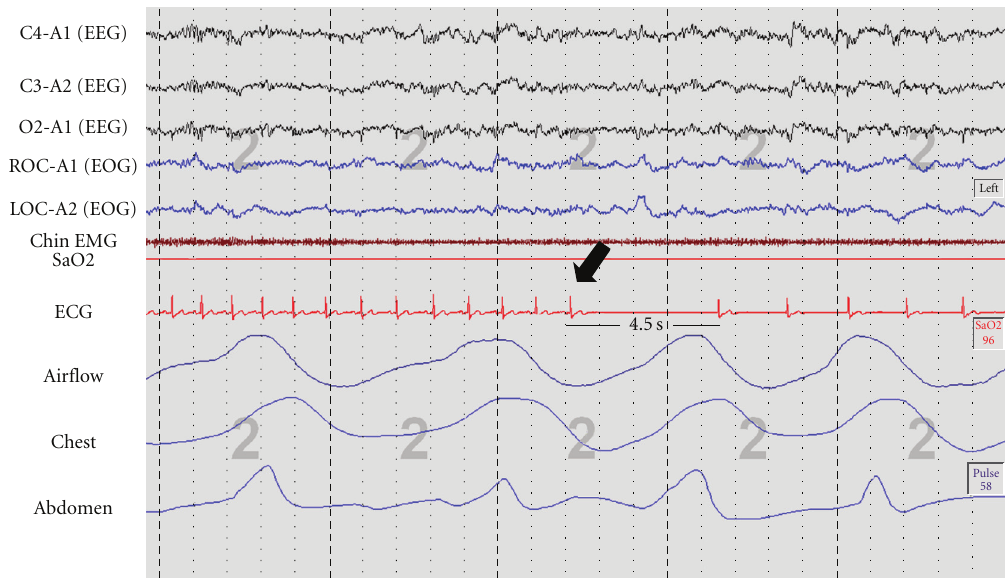
Figure 1: 25 seconds snap shot from stage 2 non-REM study in patient number 1. Black arrow shows the onset of sinus arrest lasting 4.5 seconds. After the pause, junctional rhythm is observed. Upper channels (C4-A1) (C3-A2) (O2-A1): electroencephalogram; fourth and fifth channel (ROC-A1) (LOC-A2): oculogram; sixth channel: chin electromyogram; seventh channel: oxygen saturation; eigth channel: electrocardiogram; ninth channel: airflow; tenth channel: chest movement; eleventh channel: abdomen movement.